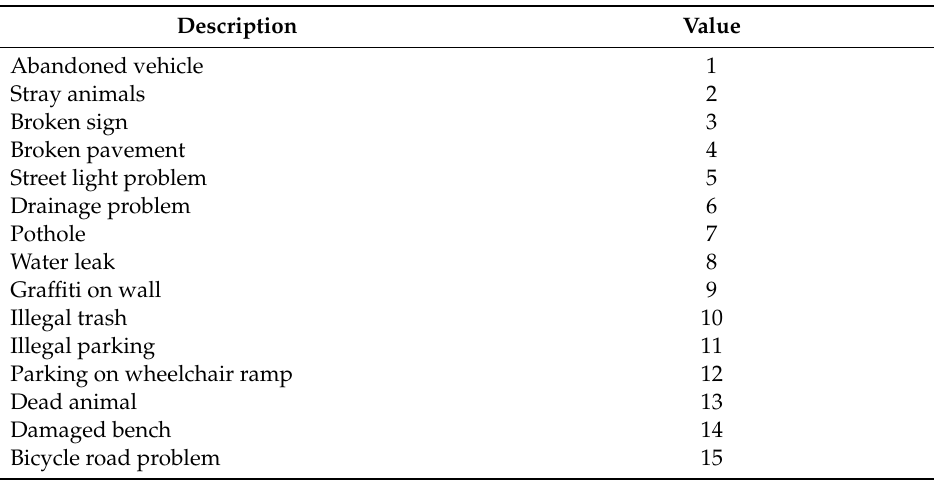
Table 4. Attribute problem value description.